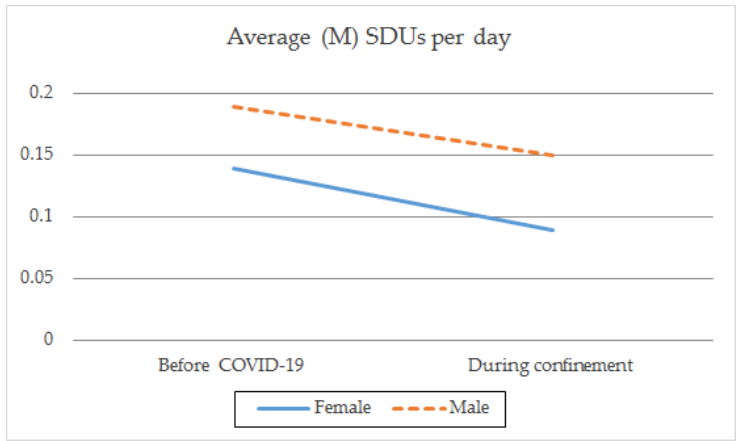
Figure 4. Average number of SDUs per day by gender before the pandemic and during COVID-19 confinement.